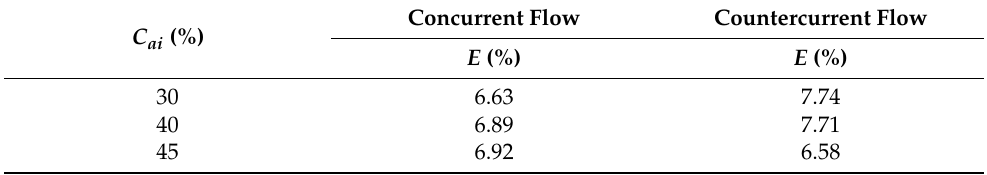
Table 3. The accuracy deviation between theoretical predictions and experimental